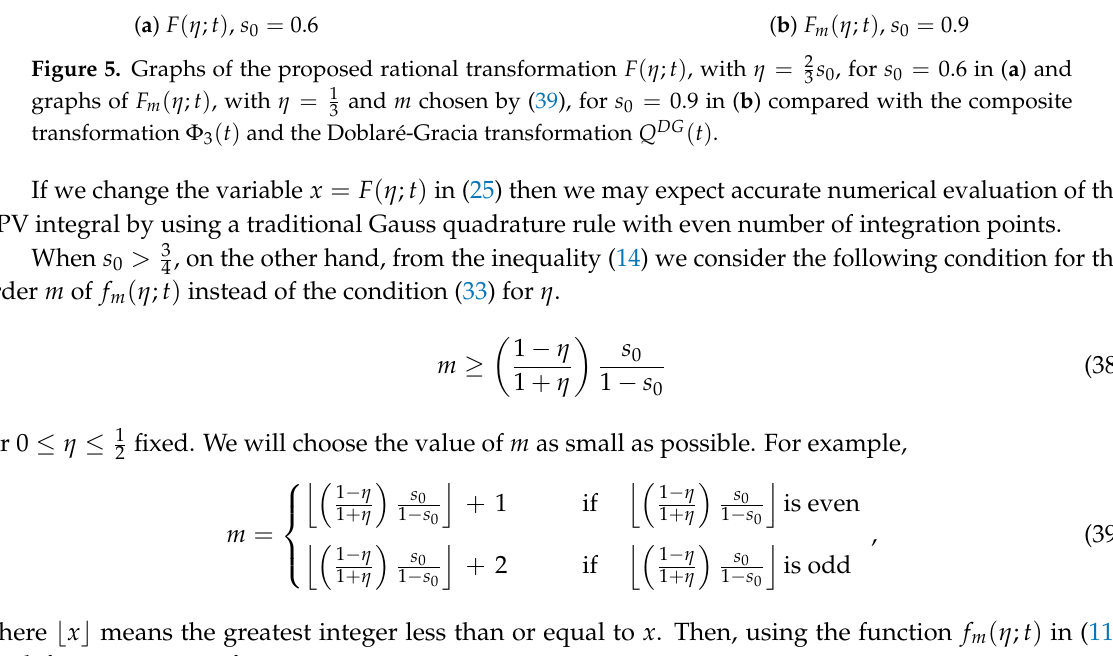
s 0 , for s 0 = 0.6 in ( a ) and 3